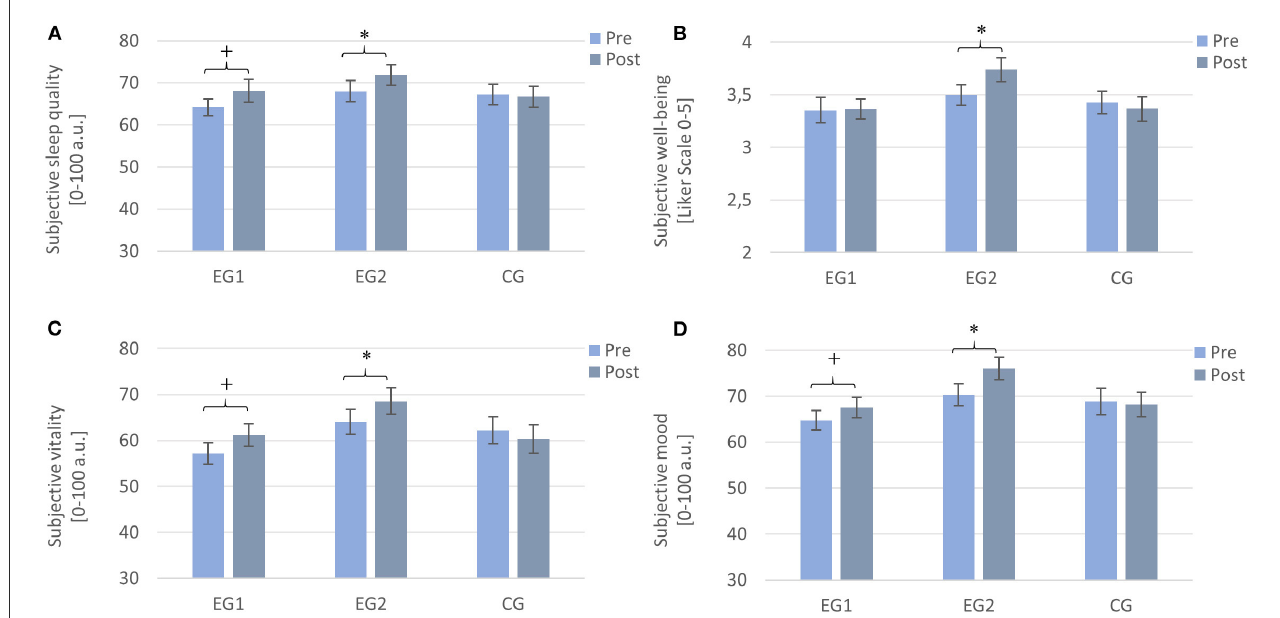
FIGURE2 Subjective values assessed by sleep diaries from pre- to post-intervention. Note that EG1 improved tendentially in (A) sleep quality, (C) vitality, and (D) mood, but not in (B) well-being, and the EG2 improved significantly on all parameters, while the CG did not show any improvements. Measurements were assessed daily and averaged over a week each. EG1 ( n = 34), EG2 ( n = 32), and CG2 ( n = 32). Asterisks represent significant results, * p < 0.05, + p < 0.10, two-tailed. Error bars display ± 1 standard error. EG1, experimental group one; EG2, experimental group two; CG, control group.